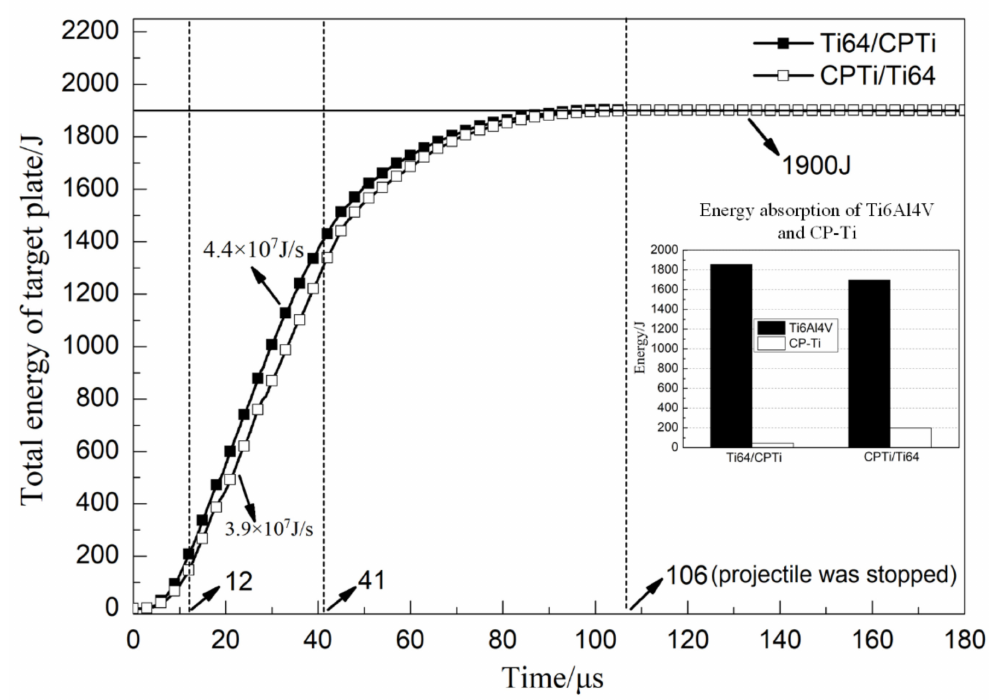
Figure 9. Total energy absorption curve of Ti64 / CPTi and CPTi / Ti64 laminated composite armor